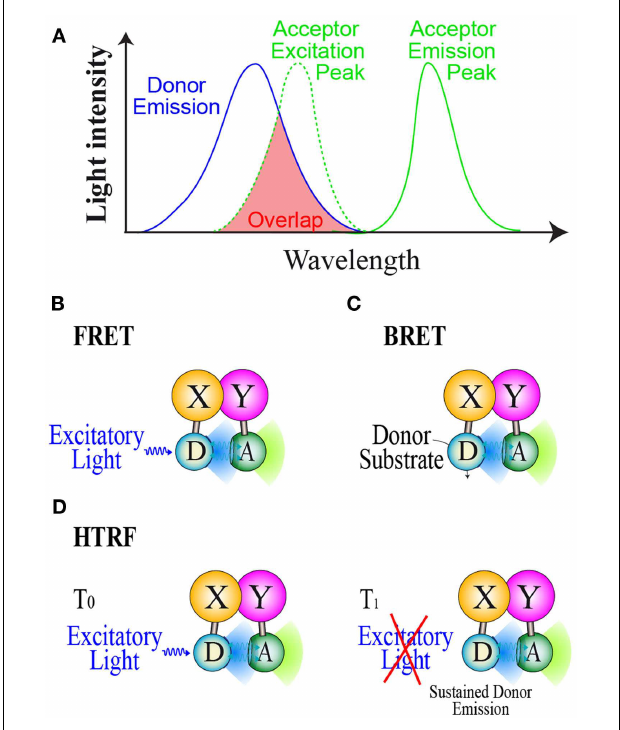
FIGURE 1 | Resonance energy transfer methods. (A) Basic properties of donor/acceptor compatible couple in order to gain RET. Principles of (B) : the FRET method, (C) :The BRET method, and (D) : the HTRF method. D, Donor; A, Acceptor; S,